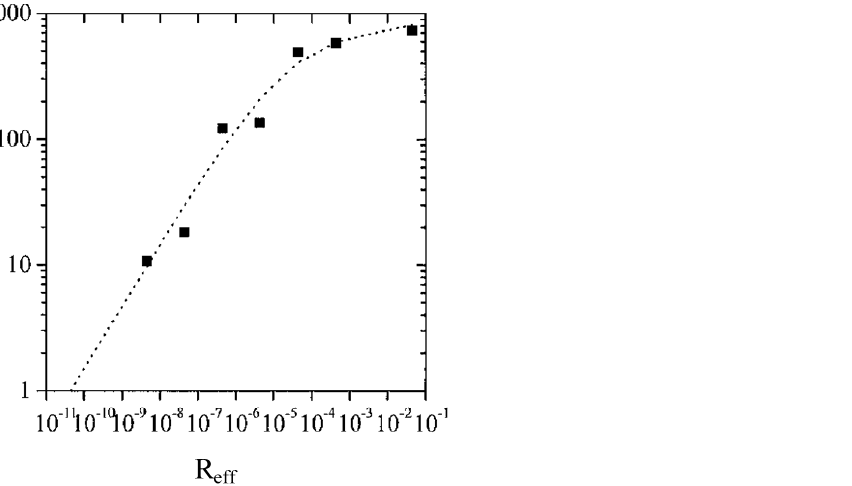
Figure 7. Experimental (symbols) and theoretical (dotted curve) evolution of the normalized RO frequency shift, where ∆ f RO is the RO frequency width (adapted with permission from [51] © The Optical Society).